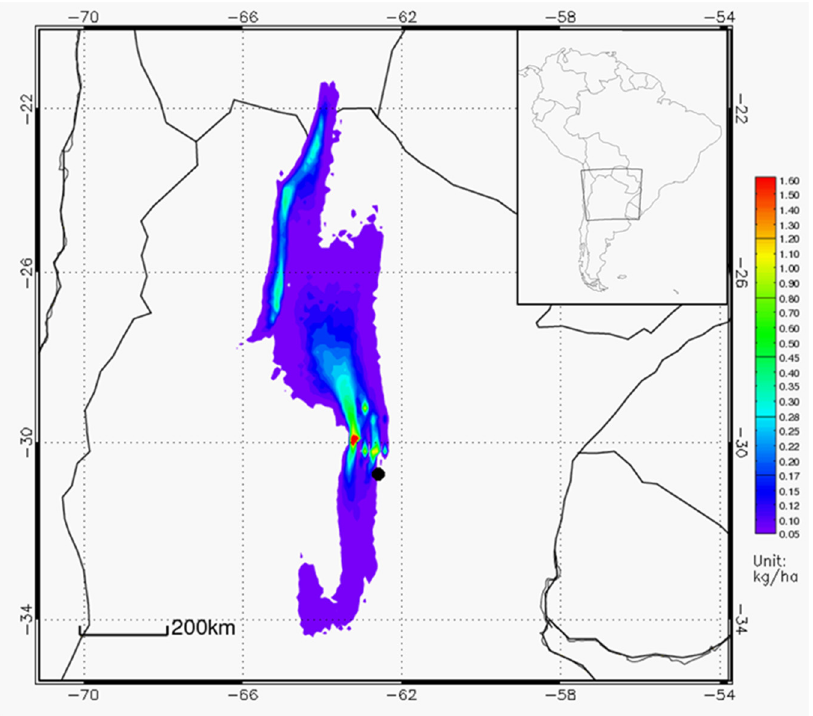
Fig 11. Model estimated annual (2009) dust deposition (kg/ha). The black dot represents the center of the Mar Chiquita